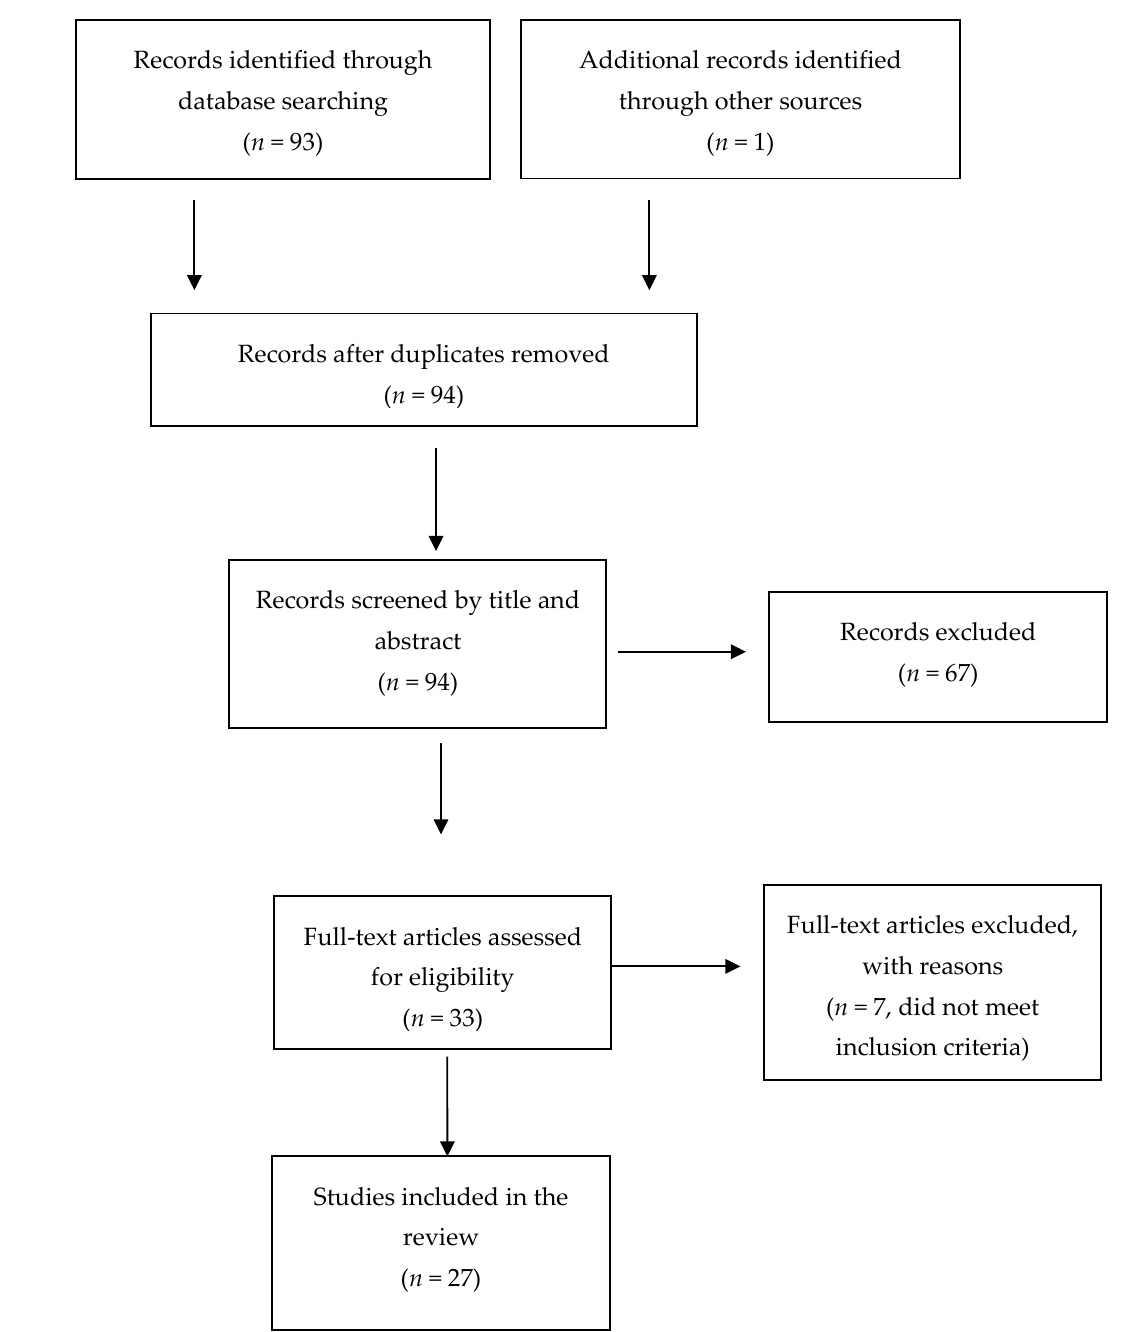
Figure 1. PRISMA flow diagram of the search strategy.